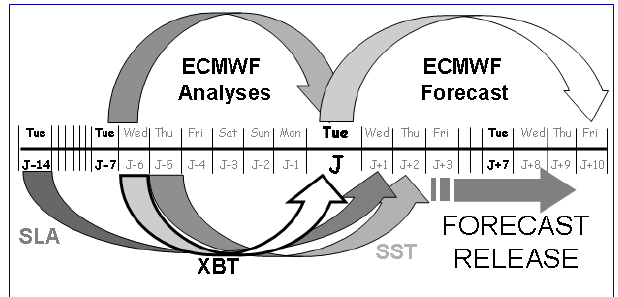
Fig. 1. Schematic NRT data collection system in MFSPP containing both oceanic and atmospheric data. The starting day of the forecast is indicated by J . Each week the system is repeated. Forecast is released Friday with three days